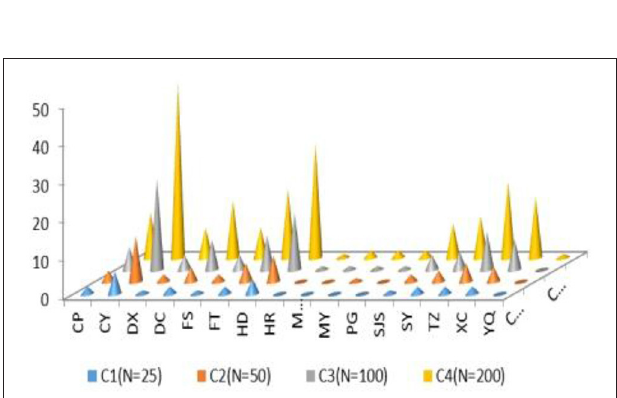
FIGURE 5 | Location of Distribution centers in Network for Last Mile Distribution for Cross-border